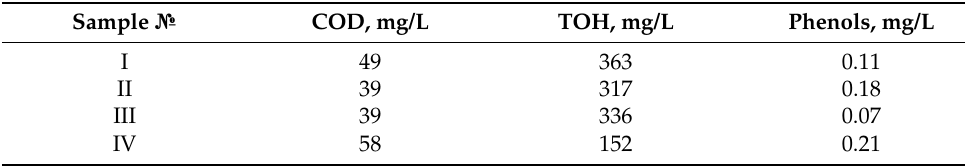
Table 3. Specific parameters for the produced